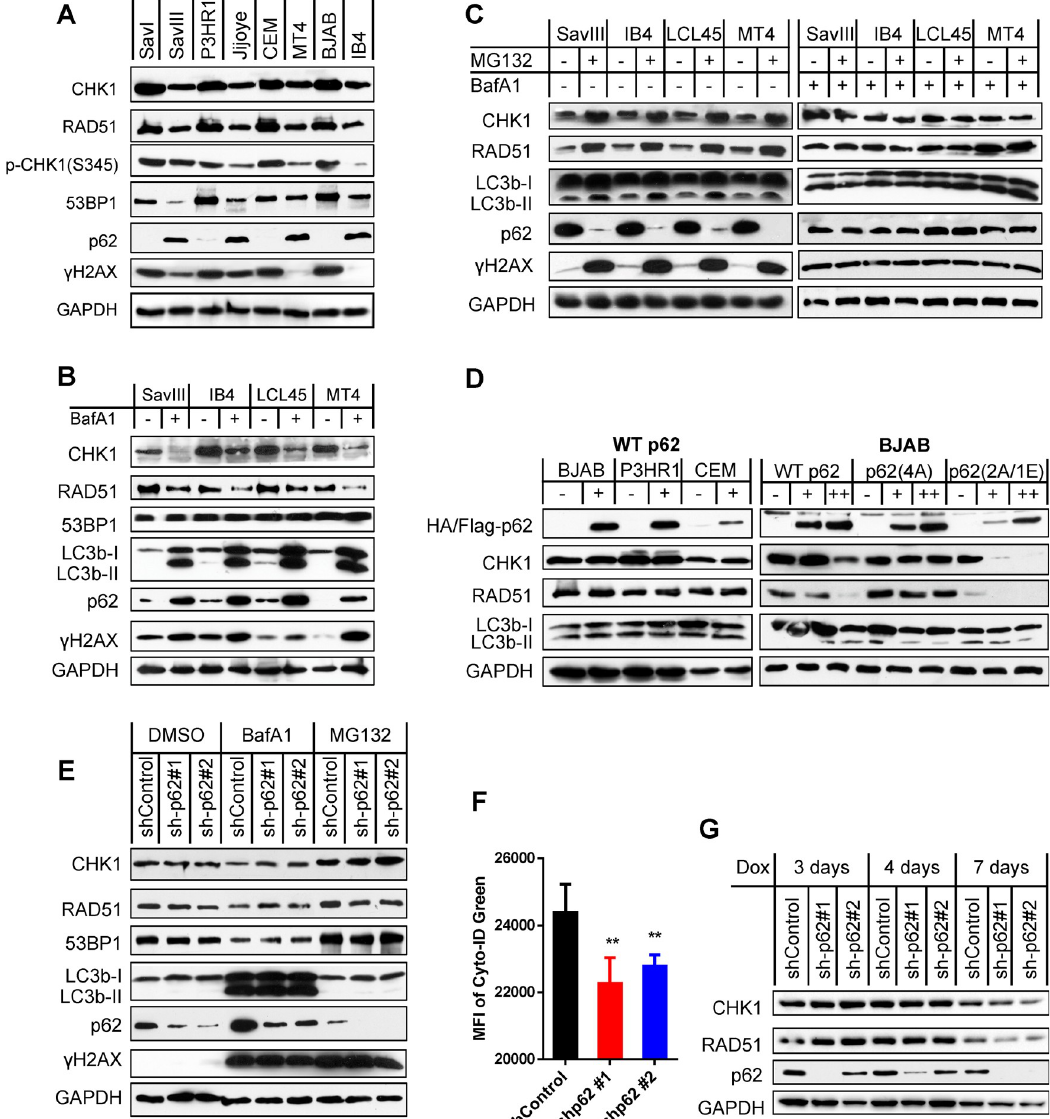
Fig 5. p62 accumulation upon autophagy inhibition destabilizes HR DNA repair proteins CHK1 and RAD51 in viral latency. A . Correlation of p62 with CHK1, RAD51 and 53BP1 protein levels in viral latency were analyzed in paired cell lines. B . Cell lines with higher levels of p62 protein were treated with 0.4 µ M BafA1 (Sigma) for 48 h. Indicated proteins were probed by immunoblotting. C . Cell lines with higher levels of p62 protein were treated with 10 µ M of the proteasome inhibitor MG132 for 6 h (left panel), or pre-treated with 0.4 µ M BafA1 before MG132. Indicated proteins were probed by immunoblotting. D . Cell lines with lower levels of p62 protein were transfected with 5 µ g (+) or 10 µ g (++) of HA-p62 plasmids, its mutants with Flag tag, or vector control in each electroporation (1X10 7 cells). Indicated proteins were analyzed by immunoblotting 48 h post-transfection. E-F . IB4 cells stably harboring p62 shRNA or shRNA control in 1 µ g/ml puromycin were treated with 0.4 µ M BafA1 for 48 h or 10 µ M MG132 for 6 h, before subjected to immunoblotting or flow cytometry. shRNA expression was induced by 1 µ g/ml doxycycline for 2 days before the drug treatments. MFI = mean fluorescence intensity. G . CHK1 and RAD51 protein stability was evaluated by immunoblotting in virus-transformed IB4 cells stably expressing control shRNA or p62 shRNA that were induced by 1 µ g/ml doxycycline for different time points. transformed cells. In addition to its ability to inhibit proteasomal activity, MG132 is capable of inducing autophagy in various cancer cells [51]. Our results show that MG132 also increases